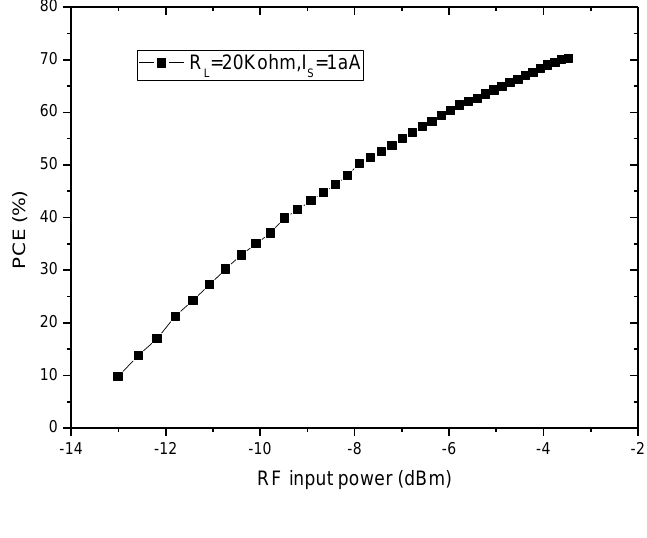
Figure 5. Power conversion efficiency with different input